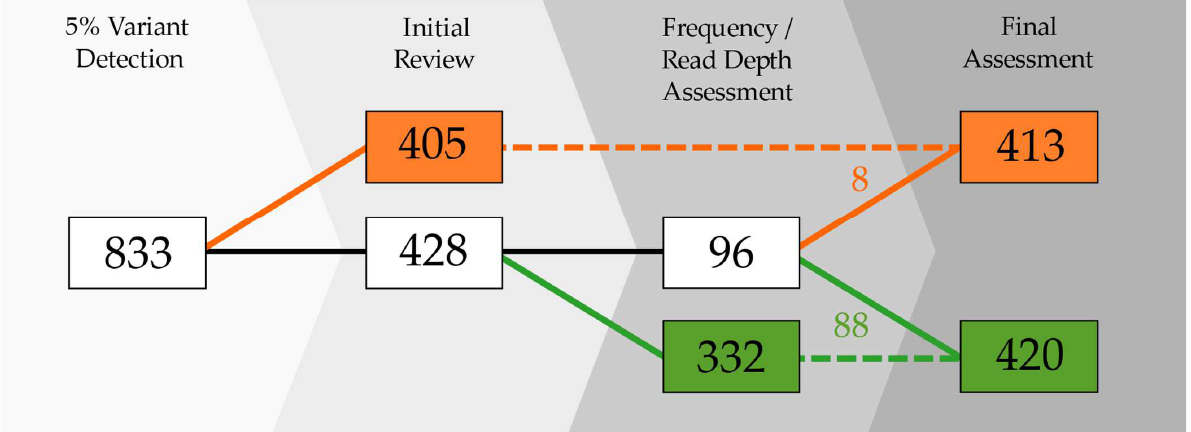
Figure 2. Classification of mixed positions that were observed in the mitochondrial genome (mito- genome) haplotypes from the SweGen whole-genome sequencing data. Mixed positions (white) were identified during initial variant detection using a 5% minimum minor nucleotide (light gray). These 833 mixed positions were detected with a 5% minor nucleotide frequency threshold and clas- sified as either nuclear mtDNA segment (NUMT) variants or point heteroplasmies (PHPs) during multiple assessments (gray gradient). The 413 NUMT variants are shown in the inner plot (orange; scale 0–60 observations) and the 420 PHPs are displayed in the outer plot (green; scale 0–35 obser- vations).